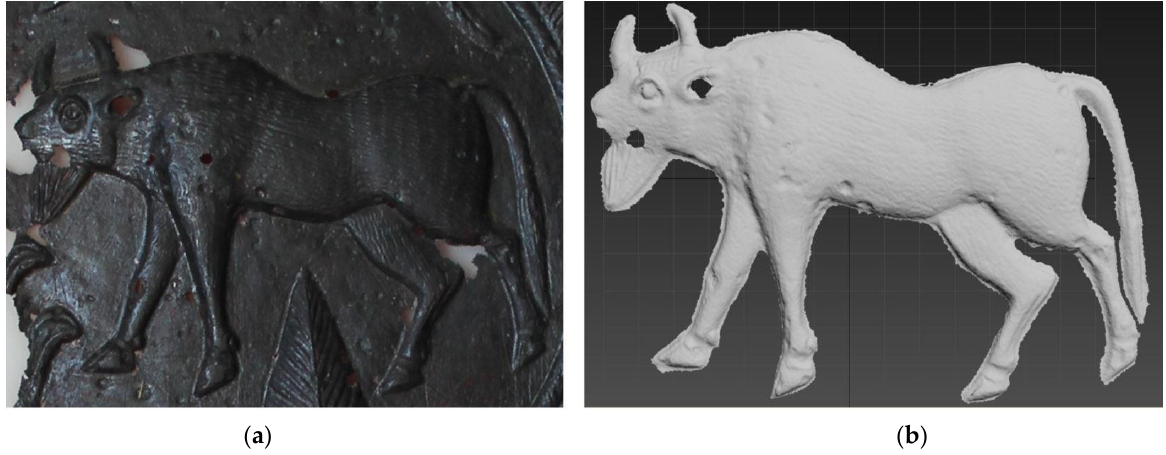
Figure 6. ( a ) Close-up photography of the aurochs ’ ornament; ( b ) The resulting cleaned 3D mesh.